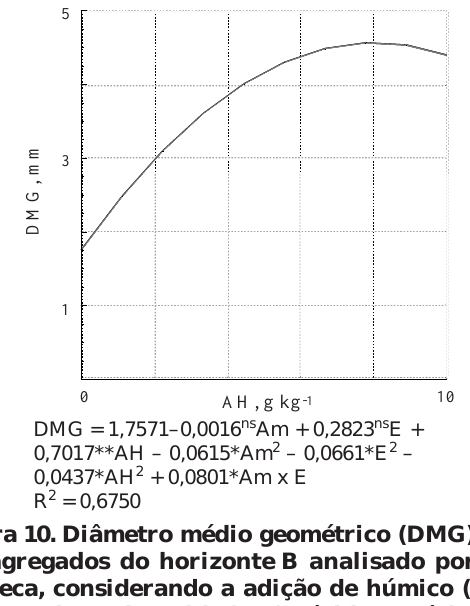
Figura 10. Diâmetro médio geométrico (DMG) dos agregados do horizonte B analisado por via seca, considerando a adição de húmico (AH), para doses de amido (Am) e ácido esteárico (E) iguais a